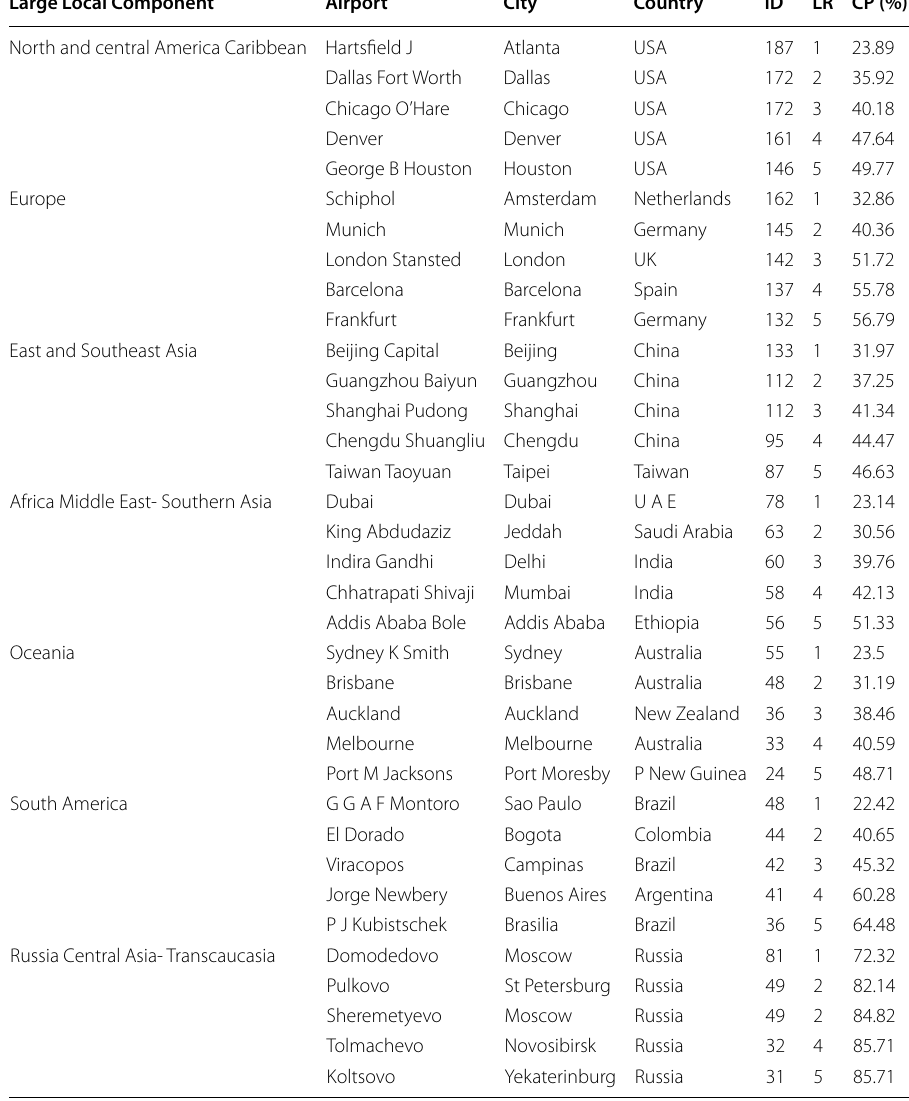
The top five hubs for each large local component are reported. ID is the internal degree. It measures the number of connections of an airport with airports located in its large local component. LR is the airport local rank in its component by decreasing internal degree. CP is the cumulative fraction of connected airports represents the proportion of airports that the top x local hubs can reach in their components